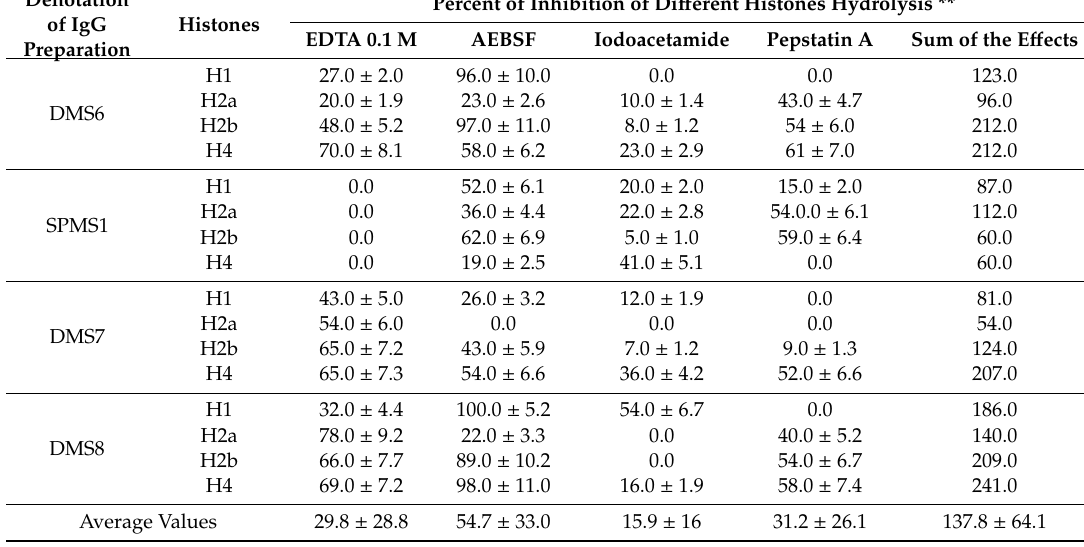
Table 2. Relative suppression of polyclonal IgGs activity from the sera MS patients in the hydrolysis of five di ff erent histones by specific inhibitors of proteases of di ff erent types *. Denotation of IgG